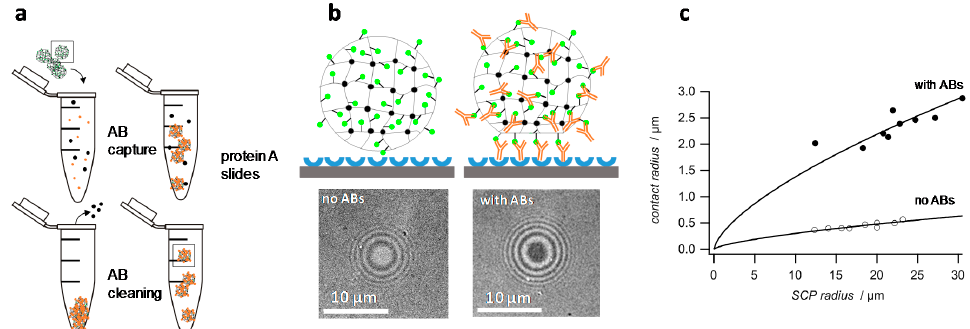
Figure 5. Procedure of the SCP adhesion assay. First BSA-FITC SCPs are incubated in antibody solution. Then they are cleaned by centrifugation and washing ( a ). Next, the SCPs adhesion is measured on protein A slided ( b ). The micrographs show images of an untreated ( left ) and antibody treated BSA-FITC SCP ( right ). After measurement of the contact area, the JKR plots reveal the adhesion energies of the SCPs ( c ). Note that drawings in ( b ) are not to scale and are presenting an idealized orientation of the binding partners for clarity.